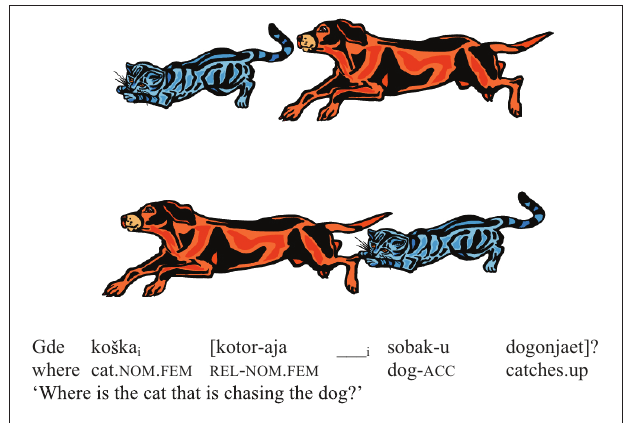
FIGURE 3 | An example item from Polinsky